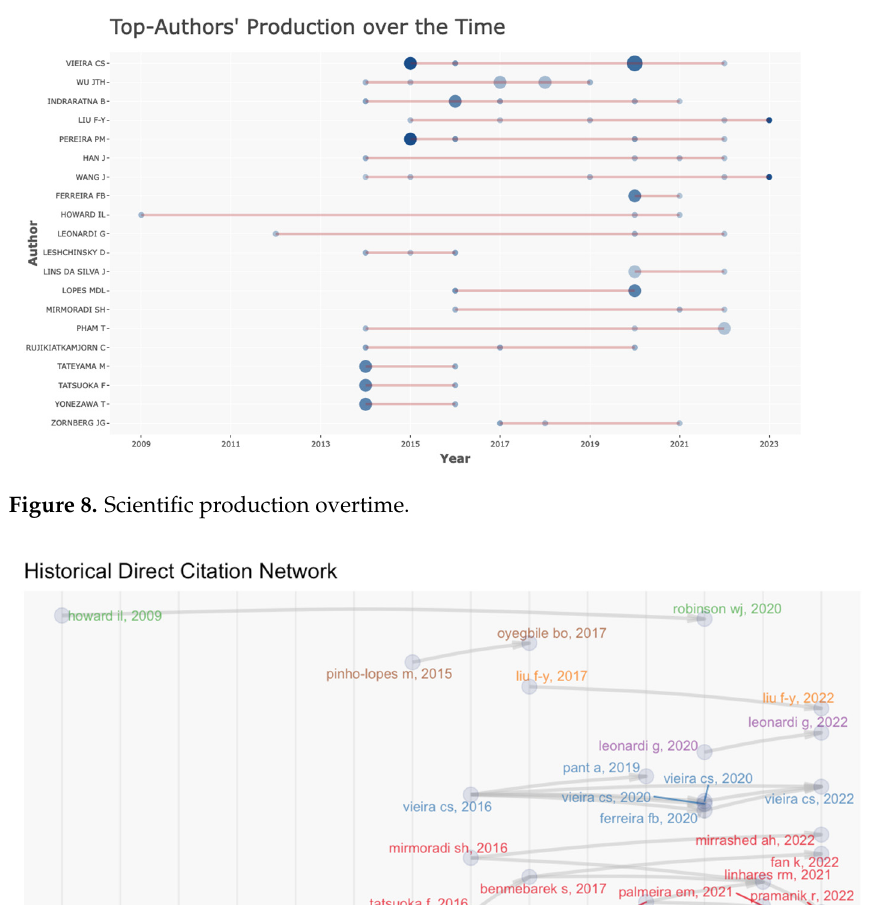
Figure 7. Frequency distribution of authors’ production.